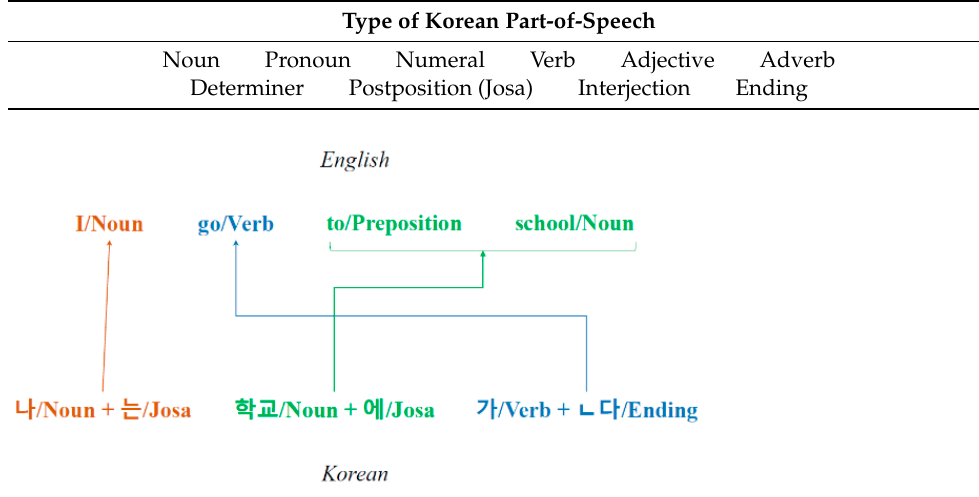
Table 4. Korean part-of-speech system.